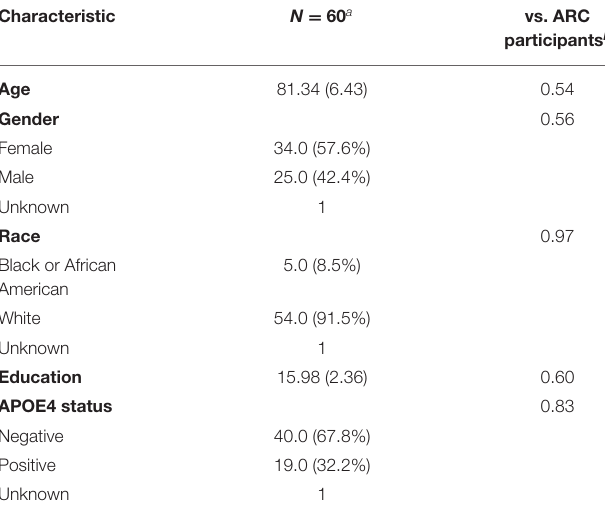
FIGURE 5 | Words used by individuals who declined to participate in the mobile assessment study.